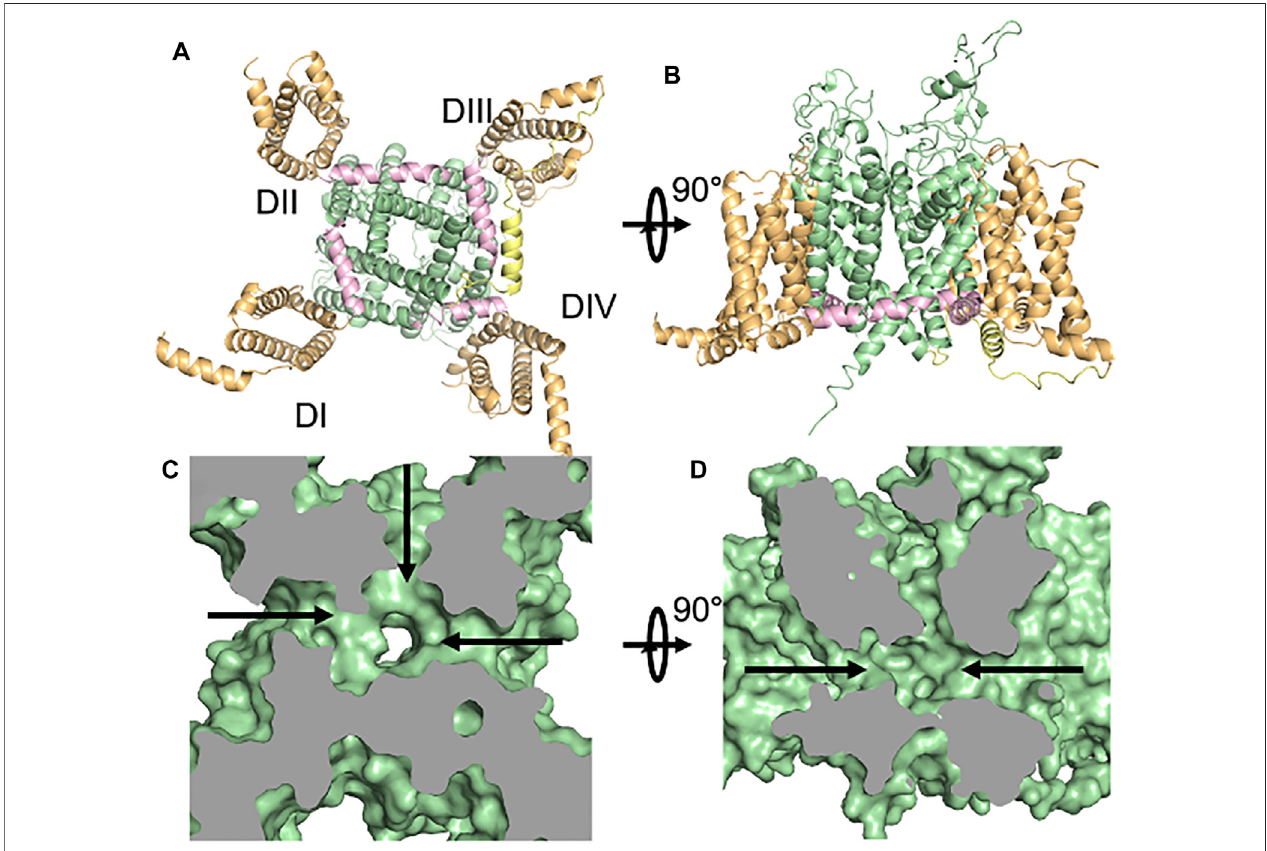
FIGURE 1 | The structure of Na v 1.5. (A,B) Orthogonal views of the cardiac sodium channel Na v 1.5 with functional regions highlighted - voltage-sensing domain (orange),poredomain(green),S4-S5Linker(pink),inactivationparticle(yellow). (C,D) .Fenestrationsinthepore-domainofNa v 1.5asshowninsurfacerepresentationsof the Cryo-EM structure. Orthogonal views of the protein ’ s van der Waals surface are shown with views as in (A,B) (Jiang et al.,